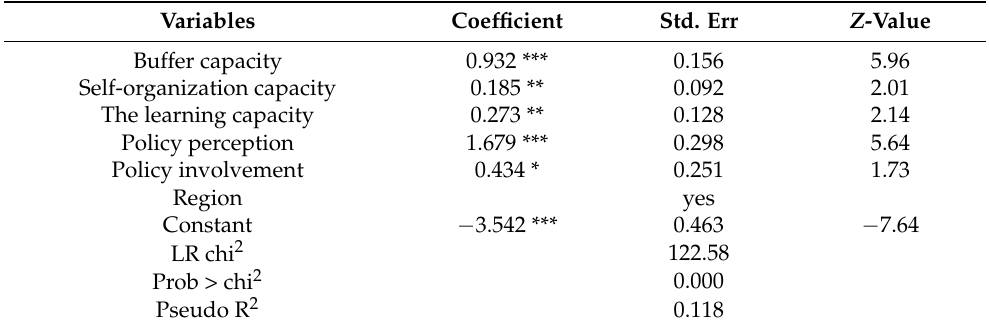
Table 3. The regression estimates of willingness to participate in tourism for rural households (total sample).